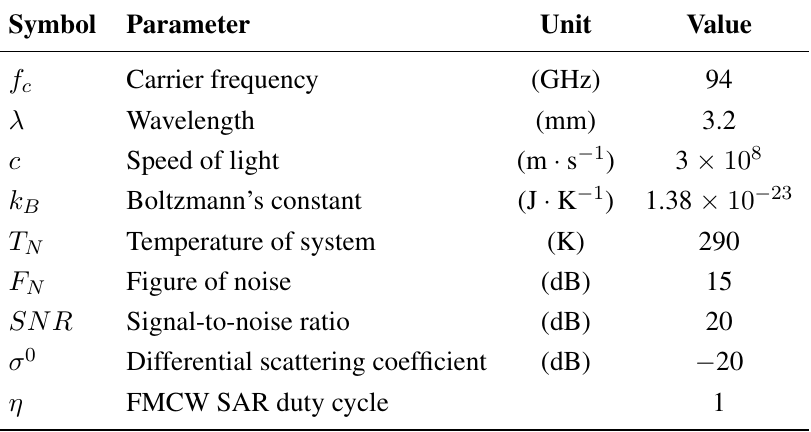
Table 4. Constant parameters for the system design.